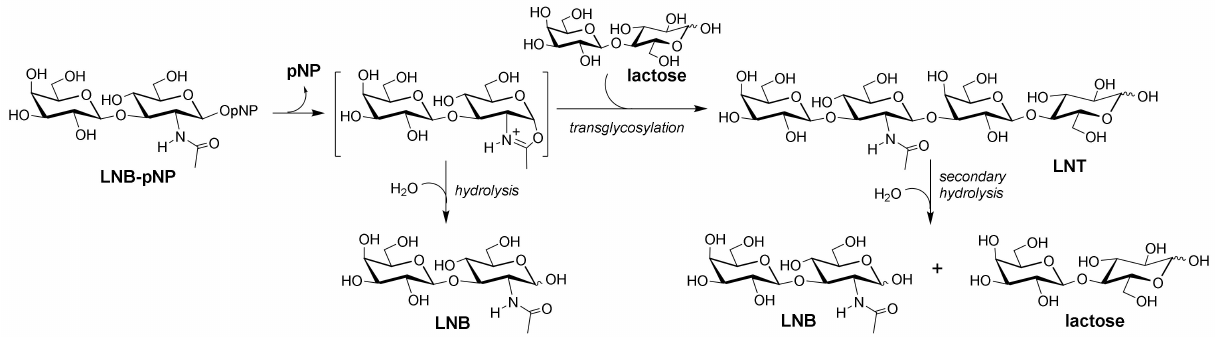
Figure 1. Synthesis of lacto- N -tetraose (LNT) by transglycosylation with engineered lacto- N -biosidase (LnbB) variants. Hydrolysis: primary hydrolysis of the donor substrate; secondary hydrolysis: hydrolysis of the